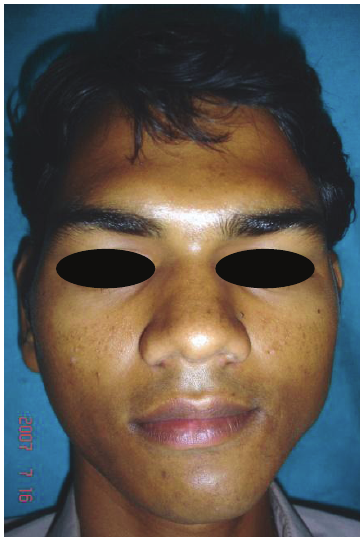
Figure 1: Pre-op frontal view.